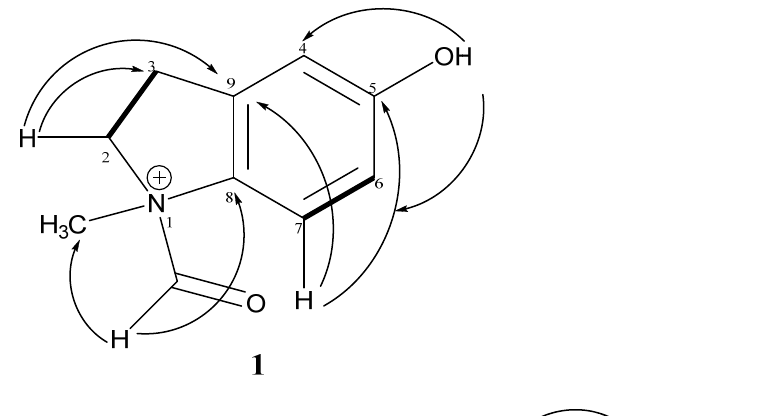
COSY Figure 3. Some correlations of compound 2 HMBC and COSY .